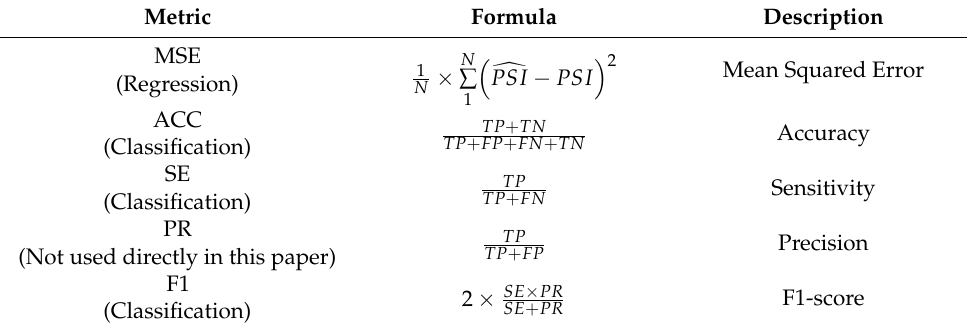
Table 1. Several regression and classification evaluation metrics. Metric Formula